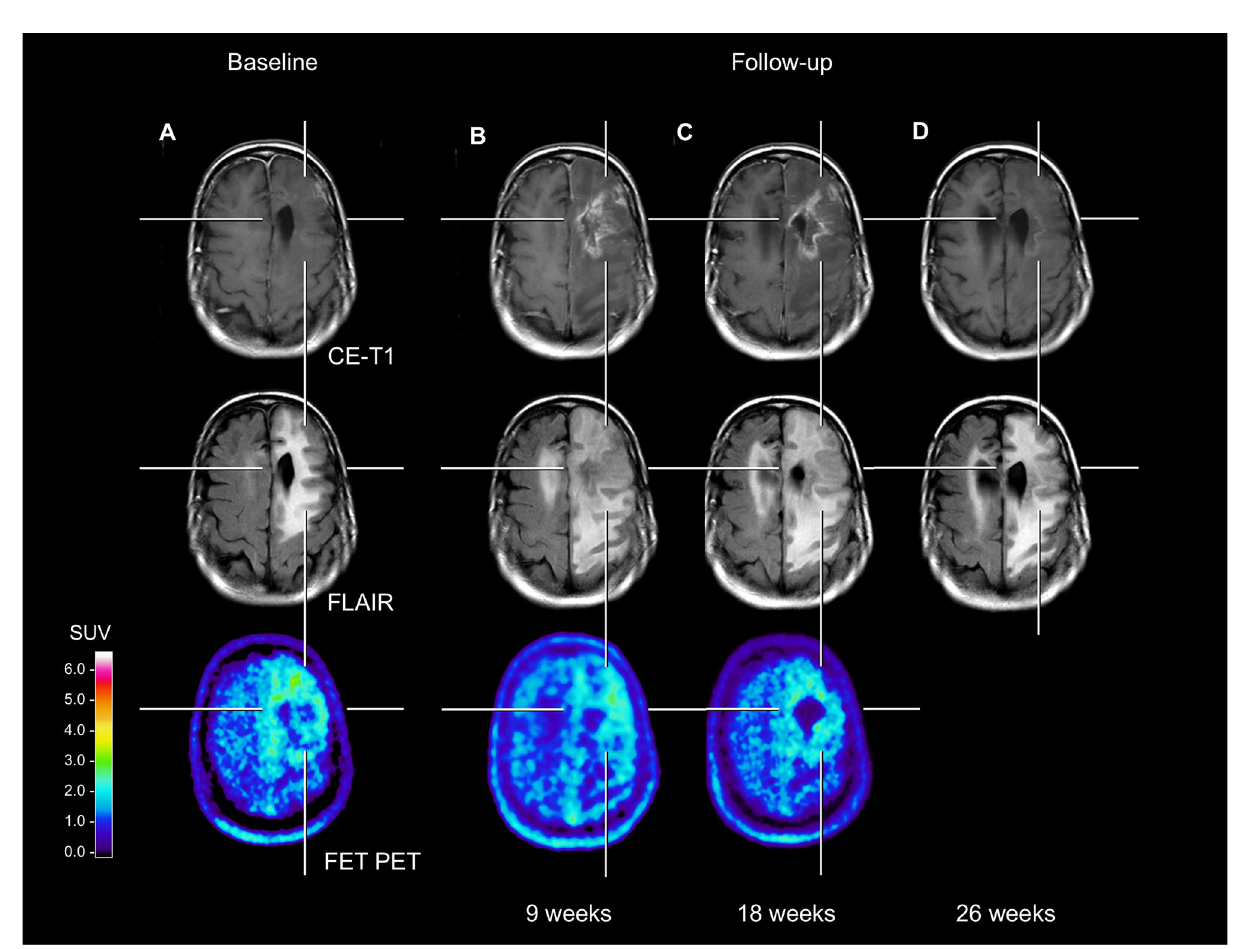
FIGURE 1 | Neuroimages including contrast-enhanced MRI, FLAIR-weighted MRI, and FET PET of a patient with an anaplastic oligodendroglioma (IDH mutant, 1p/ 19q co-deleted). Compared to the baseline MRI (A) , the follow-up MRI perfomed 9 weeks later (17 weeks after end of radiotherapy) (B) showed a substantial contrast enhancement and an extensive FLAIR signal hyperintensity in the area of the resection defect. In contrast, both the baseline and fi rst follow-up FET PET (A, B) showed no pathologically increased tracer uptake (mean tumor-to-brain ratios in both scans, 1.8). The rationale for this is based on the fact that several FET PET studies suggested that especially in pretreated glioma patients a mean tumor-to-brain ratio of 2.0 separates best between tumor relapse and treatment-related changes (1, 6, 8). The second follow-up MRI (C) showed a further slight increase of the FLAIR signal alteration. Again, the corresponding follow-up FET PET showed no substantial change of metabolic activity compared to the previous examinations (A, B) . Not earlier than 26 weeks, the third follow-up MRI (D) revealed an almost complete decrease of the contrast